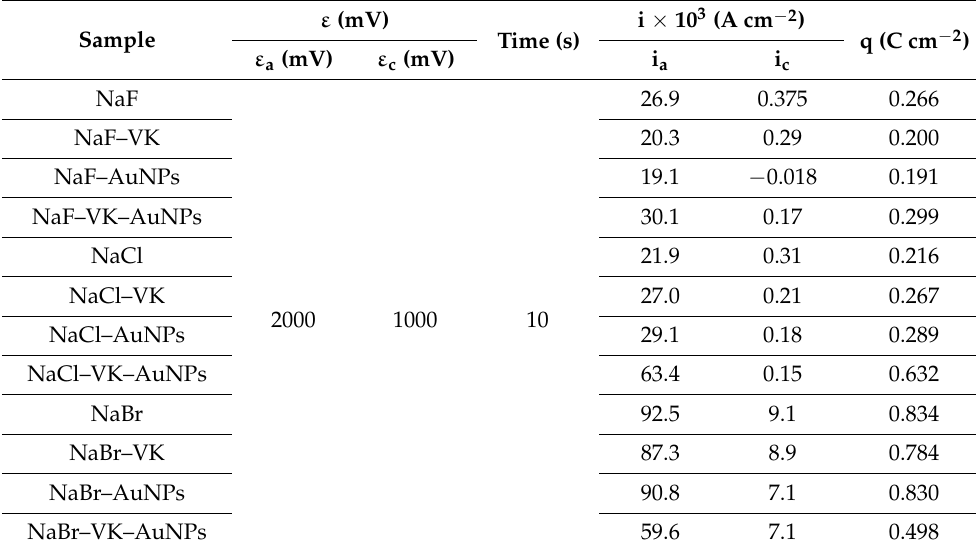
Table 1. The net amount of electric charge passed on electrode active area deduced from cyclic voltammetry recorded on platinum electrode in sodium halide solutions in potential range from 1000 mV to 2000 mV, with a scan rate of 100 mV s − 1